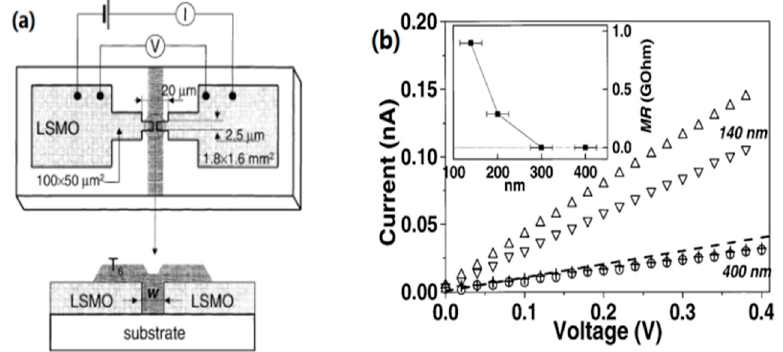
Figure 2. ( a ) The schematic of the LSMO/T 6 /LSMO lateral spin-valve device. ( b ) I-V characteristics of LSMO/T 6 /LSMO as a function of magnetic field. Down triangles and circles correspond to H = 0 Oe, while up triangles and crosses to H = 3.4 kOe. The inset indicates MR as a function of the channel length of T 6 . Adapted from [2], with permission from © 2002 Elsevier.